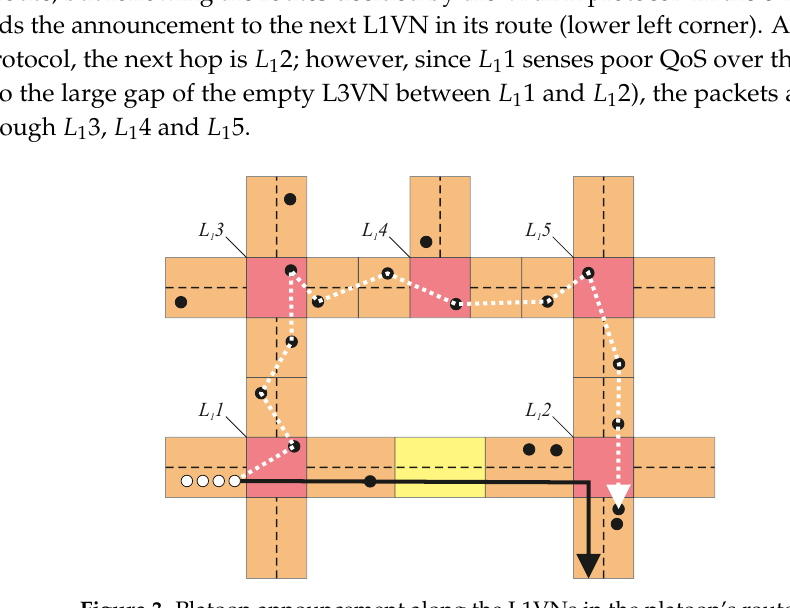
Figure 3. Platoon announcement along the L1VNs in the platoon’s